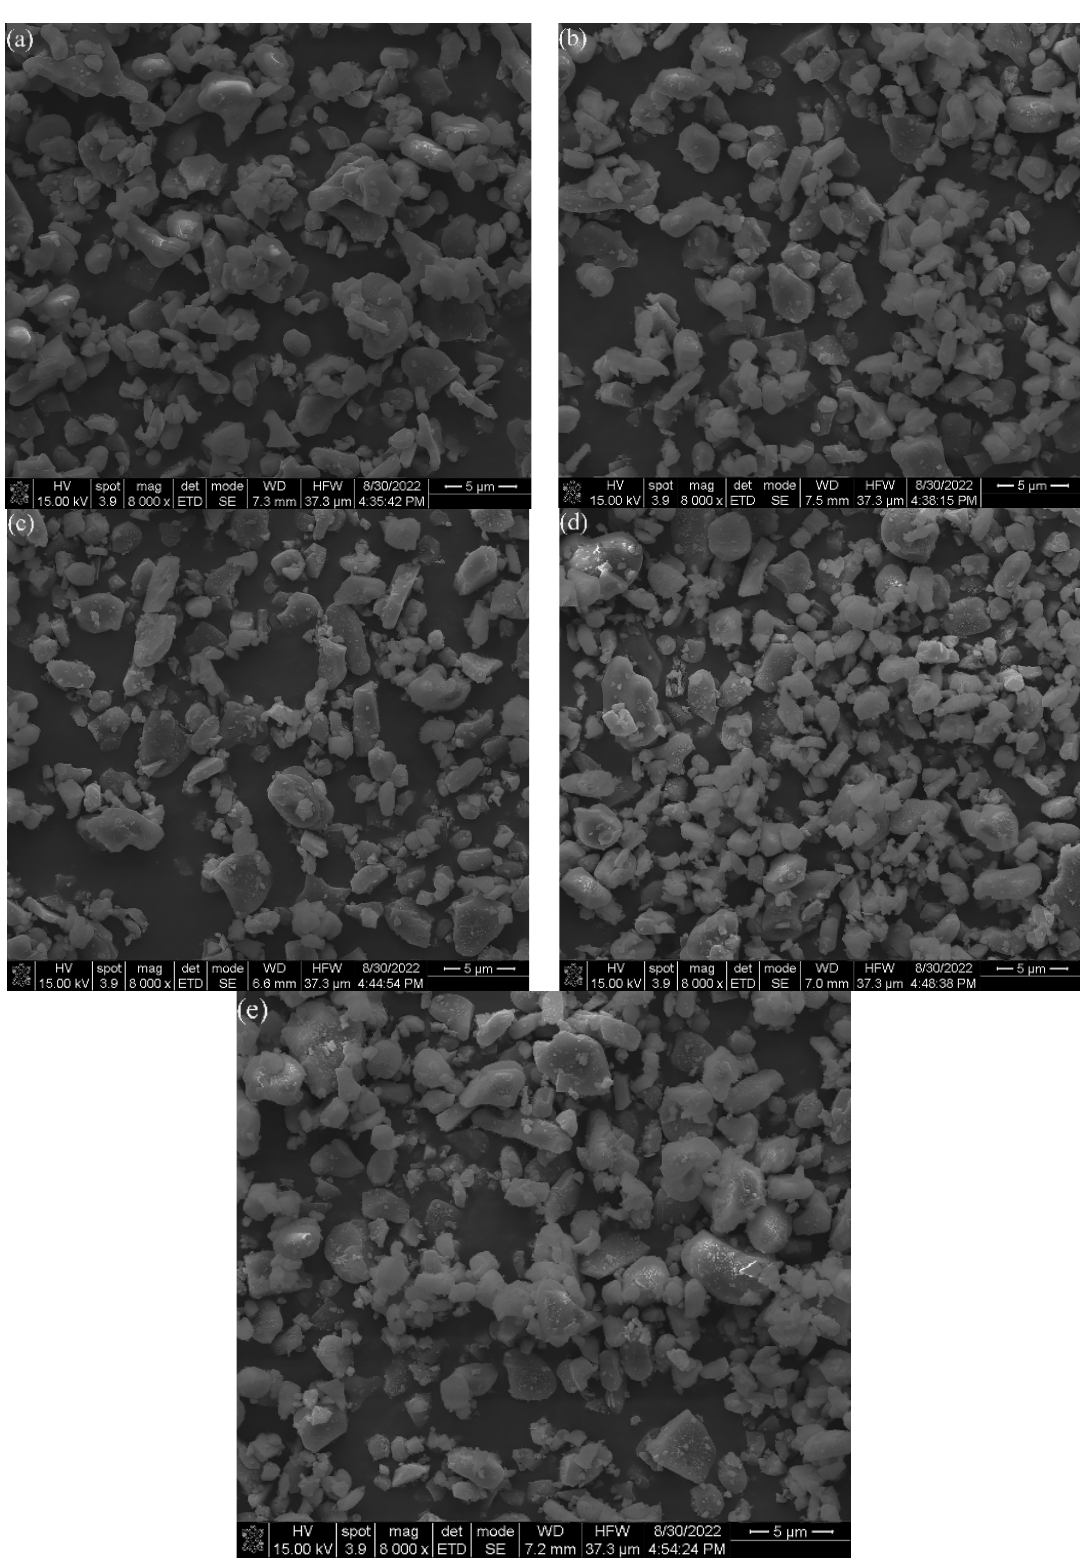
Figure 5. SEM images of Al 2 O 3 powder after different times of VM: ( a ) 1 h; ( b ) 2 h; ( c ) 3 h; ( d ) 4 h; and ( e ) 5 h.